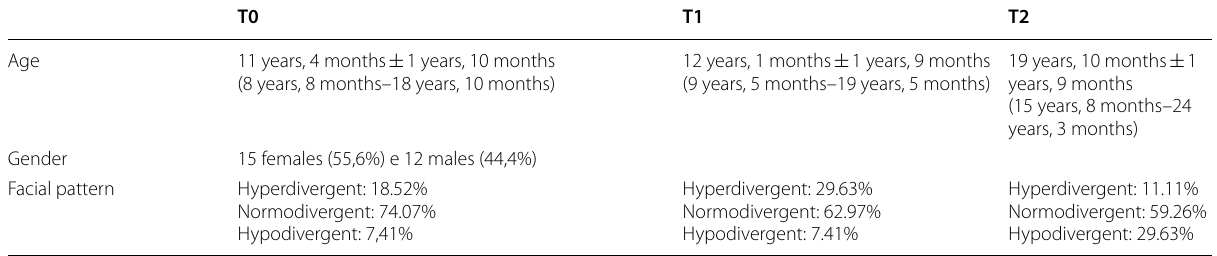
Table 1 Mean and SD age, sex and facial pattern for patients at T0 (pre-treatment), T1 (post-facemask treatment) and T2 (long-term follow up) T0 Age